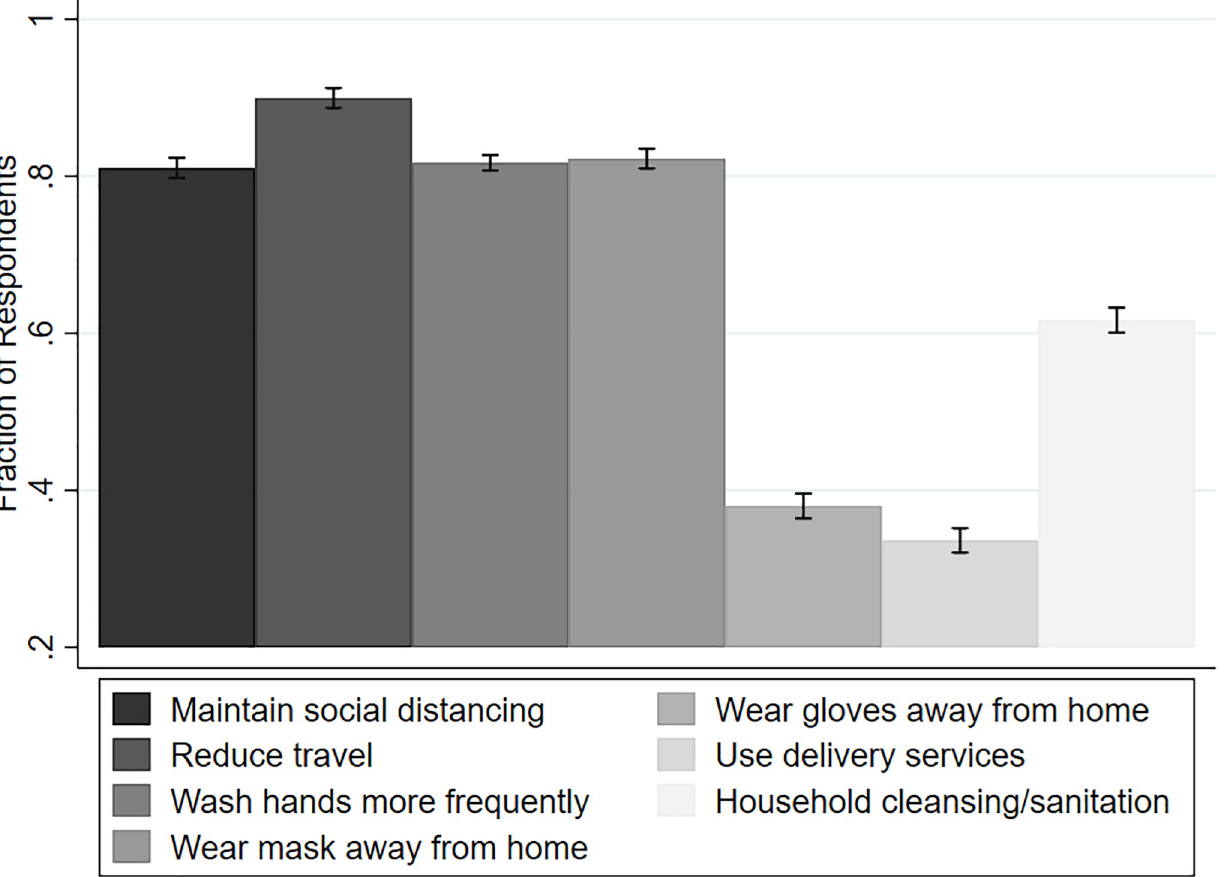
Fig 3. Fraction of respondents following each mitigation